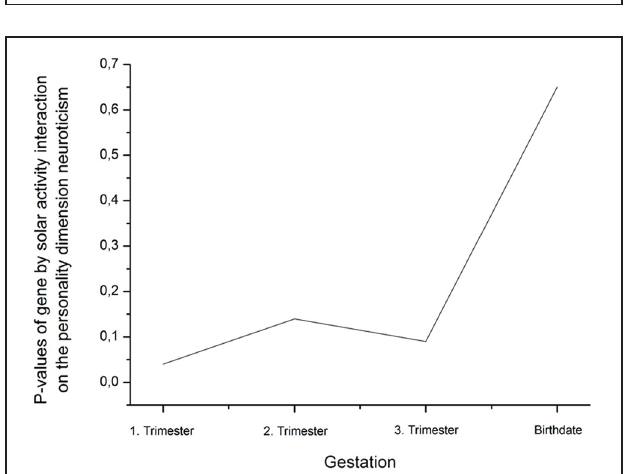
FIGURE 4 | Decline (rise of p -values) of the interaction effect gene by solar activity from the first trimester to birth on the personality dimension neuroticism ( η 2 are presented in Table